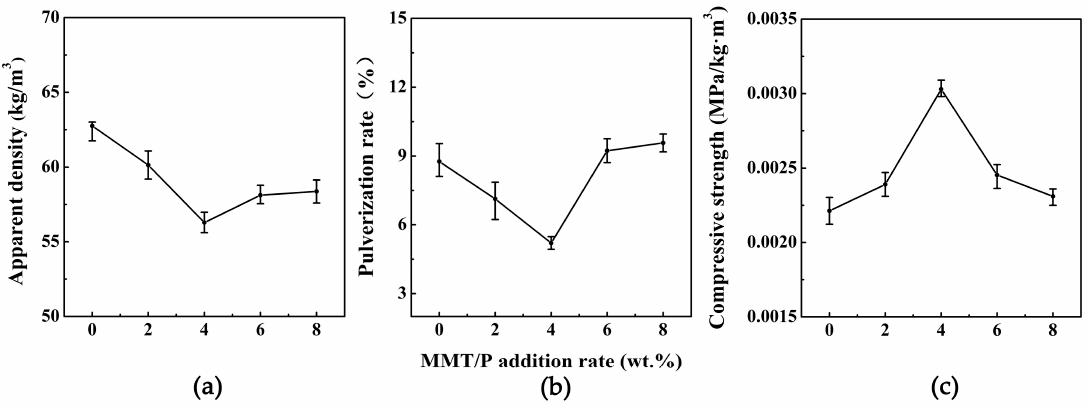
Figure 4. (a) Apparent density; (b) pulverization rate and (c) compressive strength of BPF and